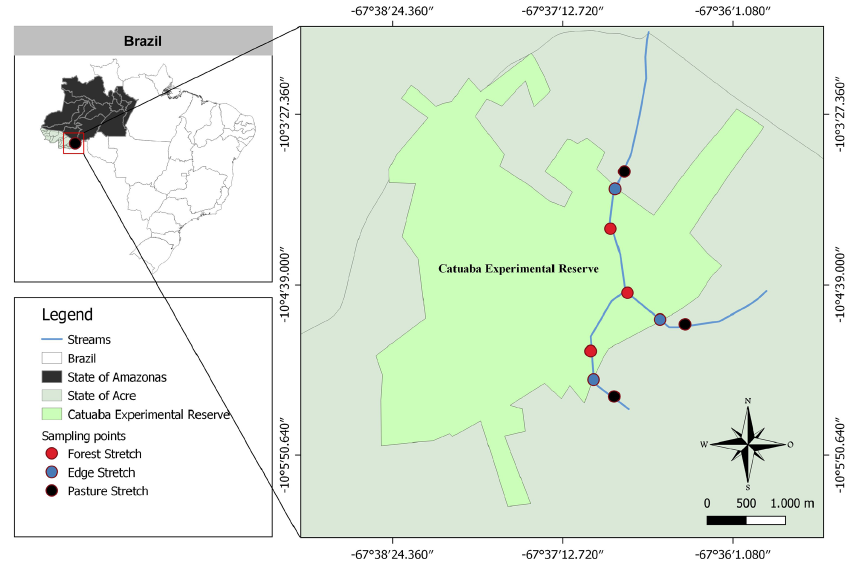
Figure 1. Geographical location of edge, forest, and pasture stretches sampled in three low-order streams of the Catuaba Experimental Reserve, municipality of Senador Guiomard, Acre,